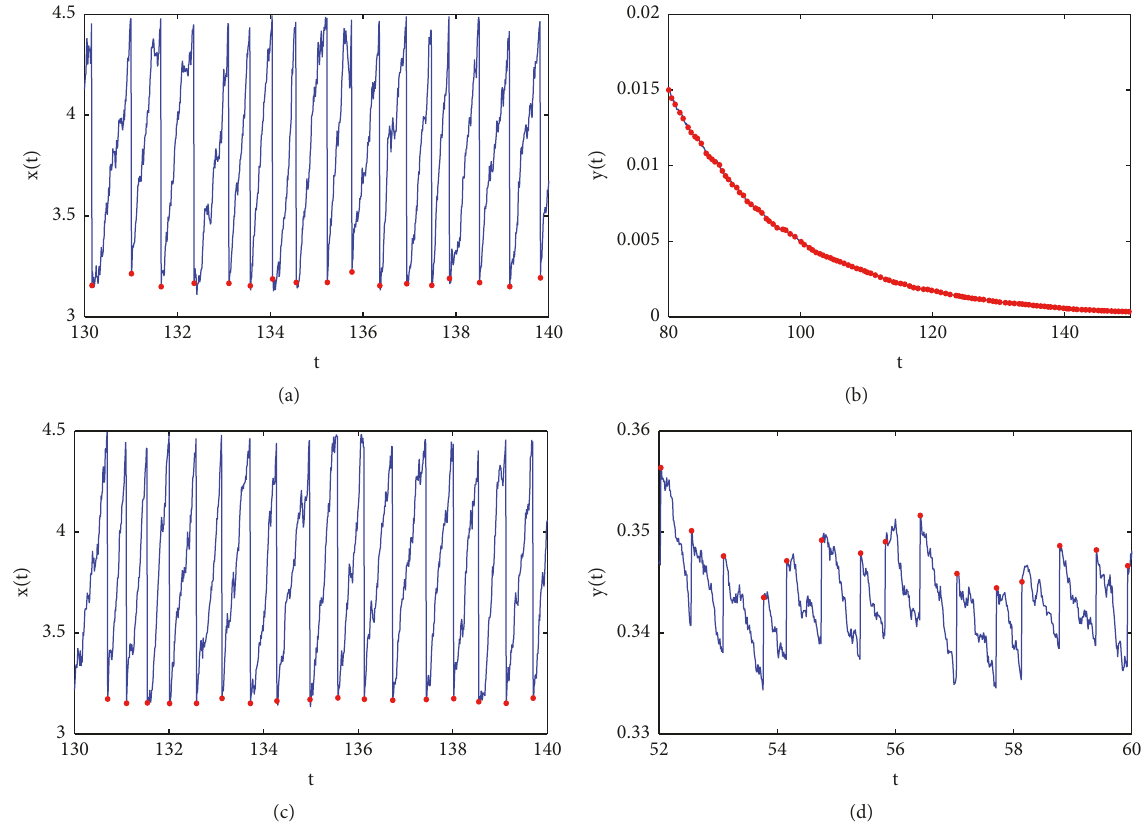
Figure 4: Two types of solutions of model (47). (a-b). Natural-enemy extinction solution with 𝜏 = 0 ; (c-d) Positive solution with 𝜏 = 0.01 . The other parameters are fixed as 𝑟 = 1,𝐾 = 10, 𝑎 = 2, 𝐷 = 0.1, 𝜇 = 0.2, 𝜃 = 0.3, 𝐸𝑇 = 4.5, 𝛼 1 = 0.1, 𝛼 2 = 0.015